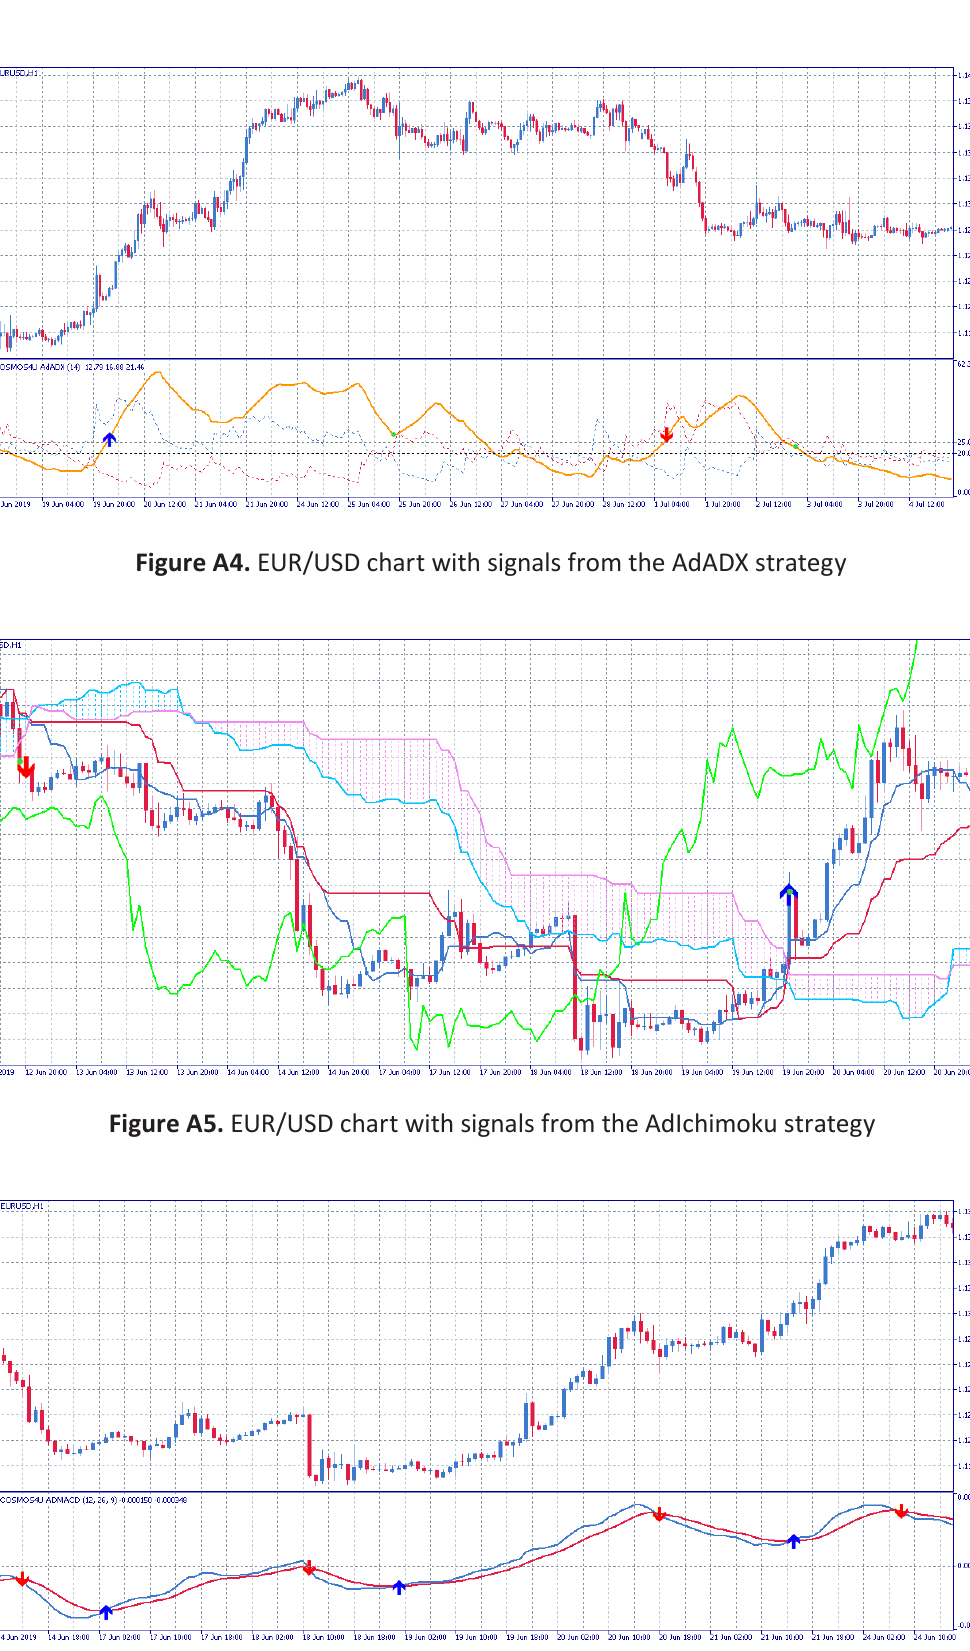
Figure A6. EUR/USD chart with signals from the AdMACD